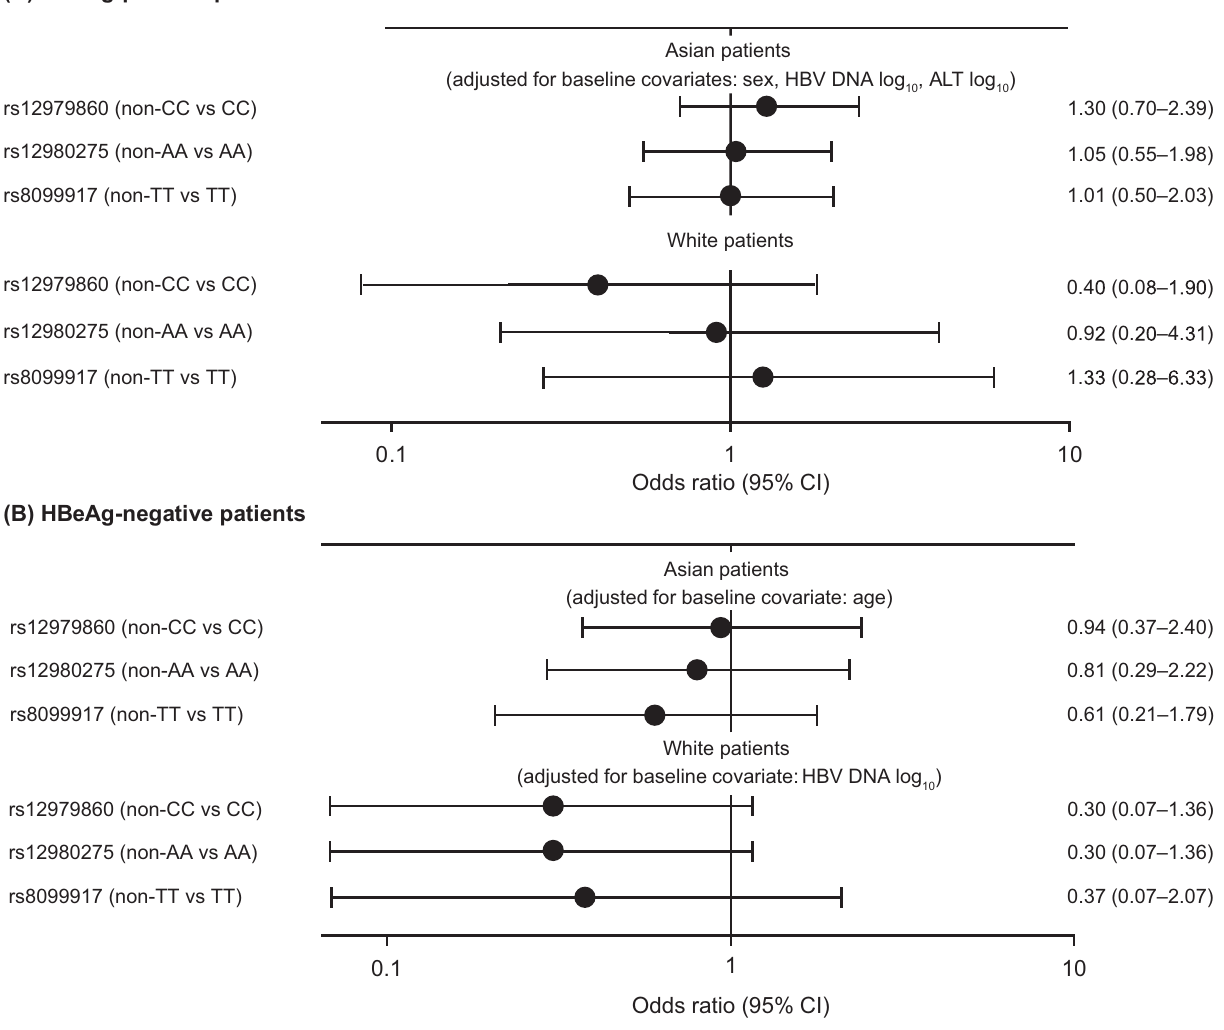
Fig 3. Associations between baseline covariates and treatment outcome in multivariate logistic regression analyses. Associations are shown for HBeAg-positive (A) and HBeAg-negative (B) patients. ALT, alanine aminotransferase; HBeAg, hepatitis B e antigen; HBV, hepatitis B virus.